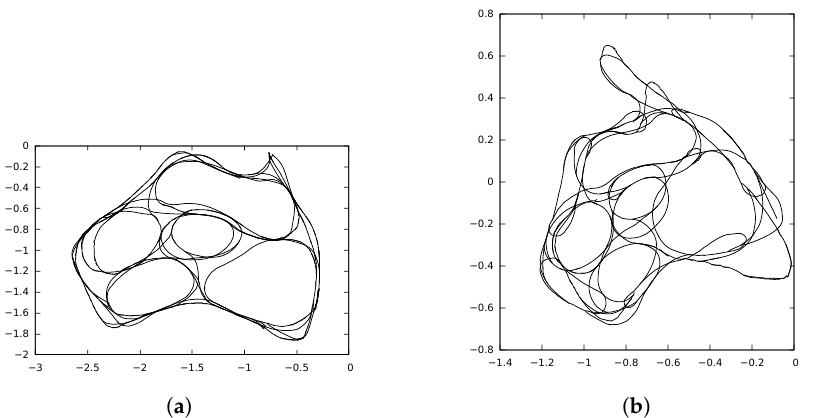
Figure 9. ExperienceMap comparison between different odometry sources. ( a ) ExperienceMap using odometry information read from iRat robot. ( b ) ExperienceMap using odometry information generated by visual odometry with parameters empirically